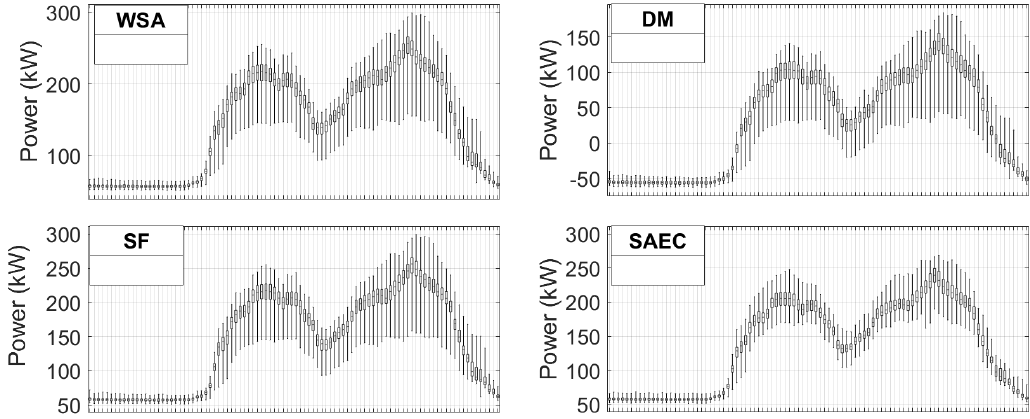
Figure 13. Electricity consumption pattern represented by box-plots for a working Wednesday; Universidad Politécnica